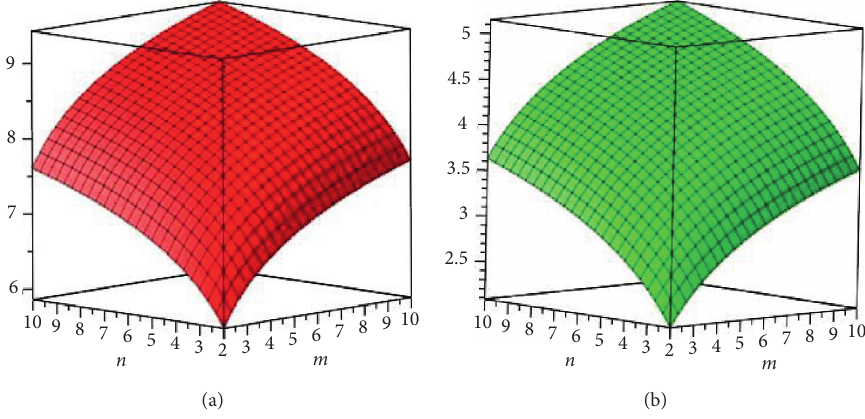
Figure 5: (a) Randi´c entropy for α � 1; (b) Randi´c entropy for α � − 1.